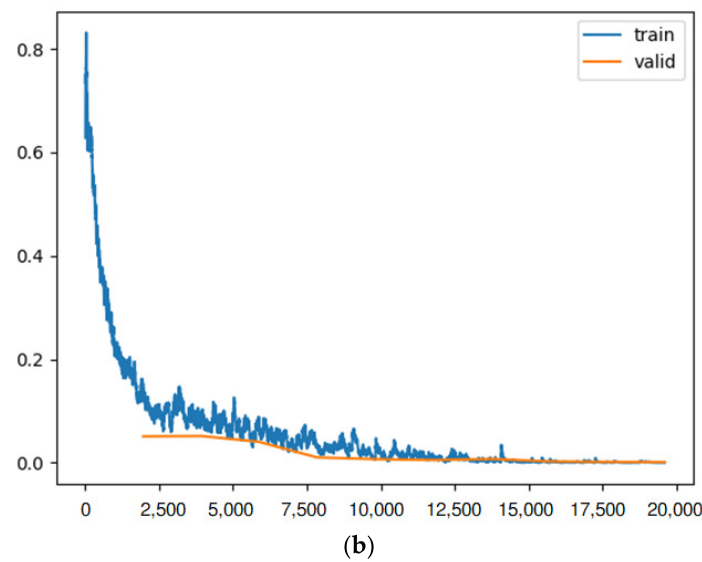
Figure 10. ( a ) Confusion matrix and ( b ) loss rate during training with ResNet18.